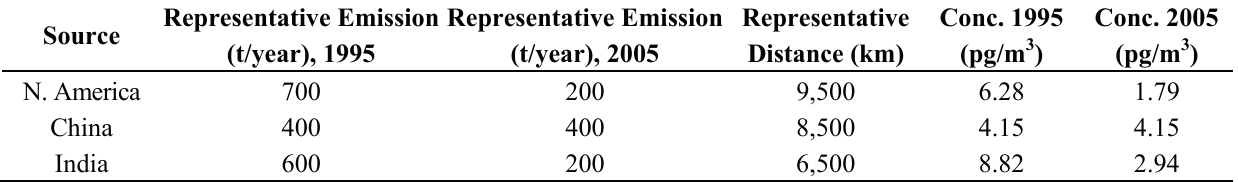
Table 2. Representative emissions of lindane as reported by [32,48] and predicted background atmospheric concentrations (pg/m 3 ).